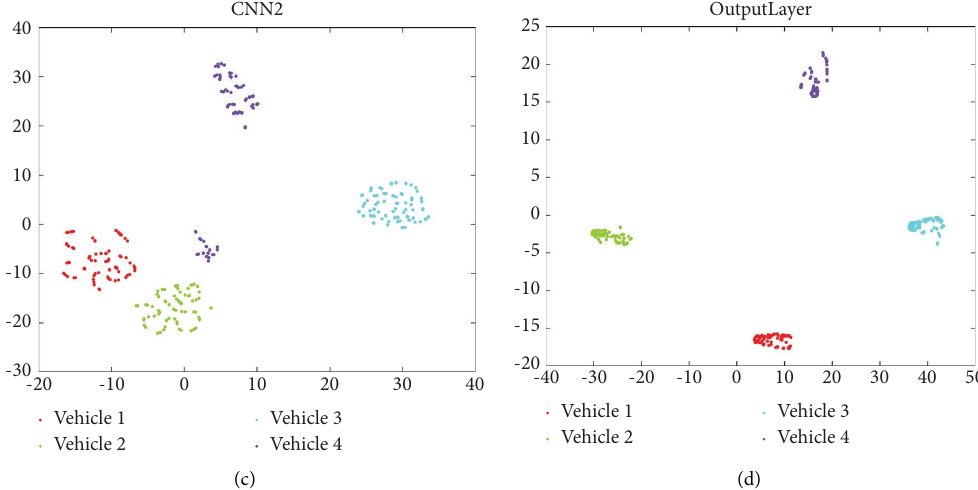
Figure 8: t-SNE visualization of characteristics. (a) Data characteristics of the input layer, (b) data characteristics of the frst CNN layer, (c) data characteristics of the second CNN layer, and (d) data characteristics of the output